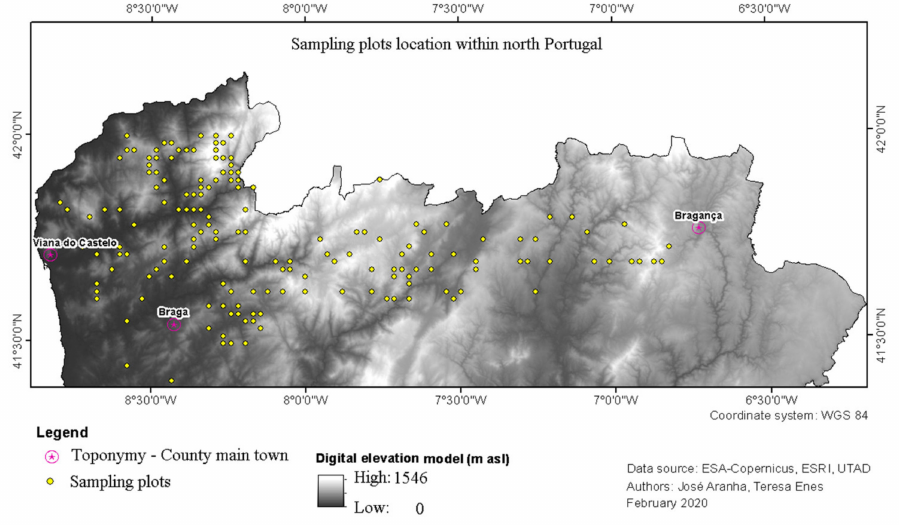
Figure 2. Sampling plots